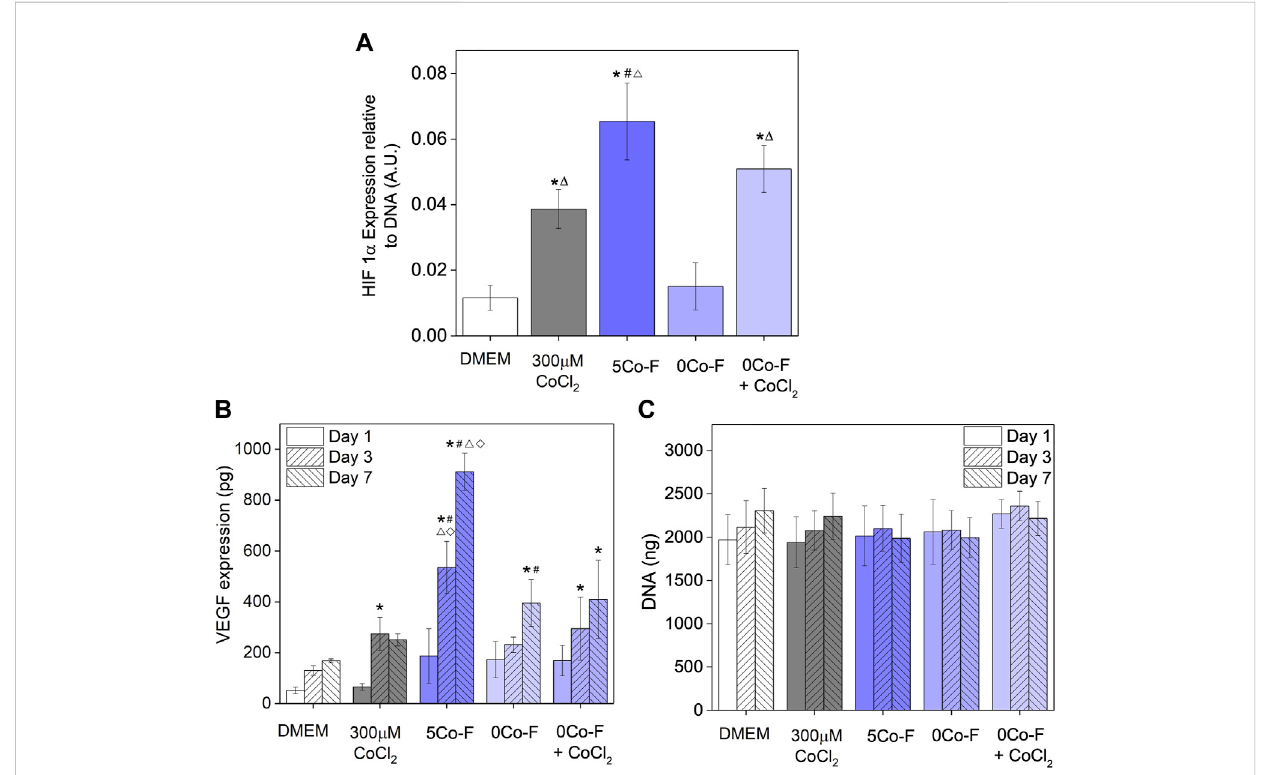
FIGURE 5 Results of in vitro studies of keratinocytes exposed to conditioned media from the glass fi bres: Increase in HIF-1 α measured after 4 h (A) ; VEGF expression (B) ; and total DNA (C) . Data is represented as mean ± standard deviation with N = 4. For Fig B and C the 0Co-F + CoCl 2 condition is representedasN=3forDay1and3,andn=2forDay7.Statisticalsigni fi cancewasdeterminedwitha (A) onewayANOVAor (B) and (C) twowayANOVA, withaTukeymeanscomparisontestwith* p < 0.05compared toDMEM,# p < 0.05 compared to300 μ MCoCl 2 , Δ p < 0.05compared to0Co-Fand ◇ p < 0.05 compared to 0Co-F + CoCl 2